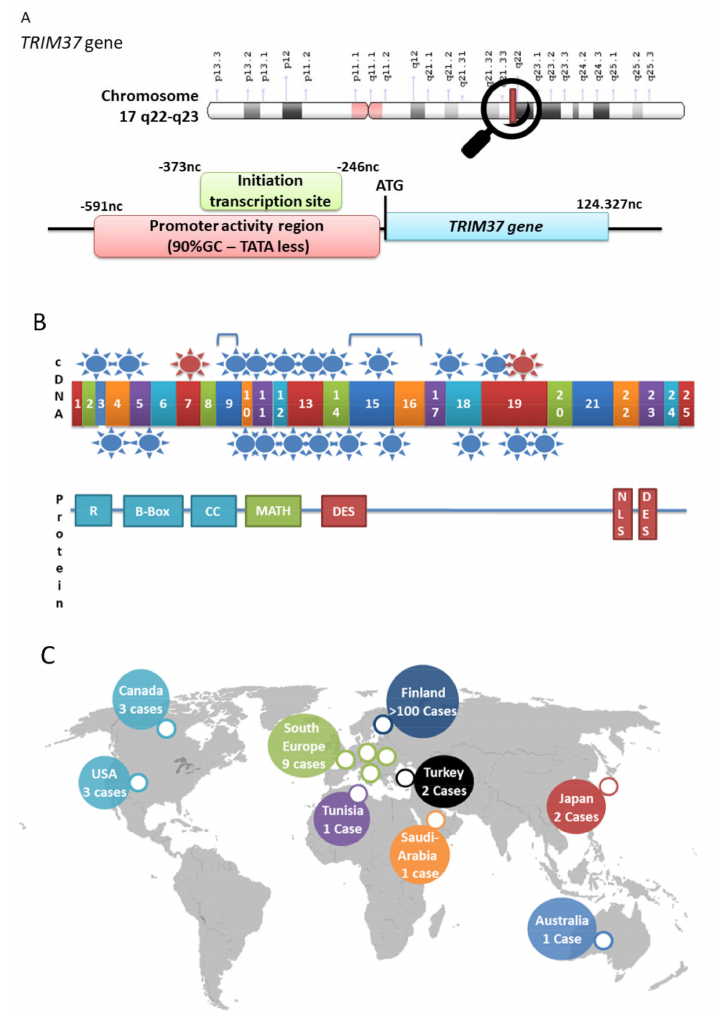
Figure 2. The TRIM37 gene. ( A ) Schematic presentation of the MULIBREY-nanism-associated gene and TRIM37 localization and gene structure. ( B ) cDNA, protein structure, and localization of mutations. Red circles correspond to the Finnish major and minor mutations; blue circles correspond to other mutations. Exons are numbered from 1 to 25. ( C ) Localization of mutations found in the TRIM37 gene all around the world